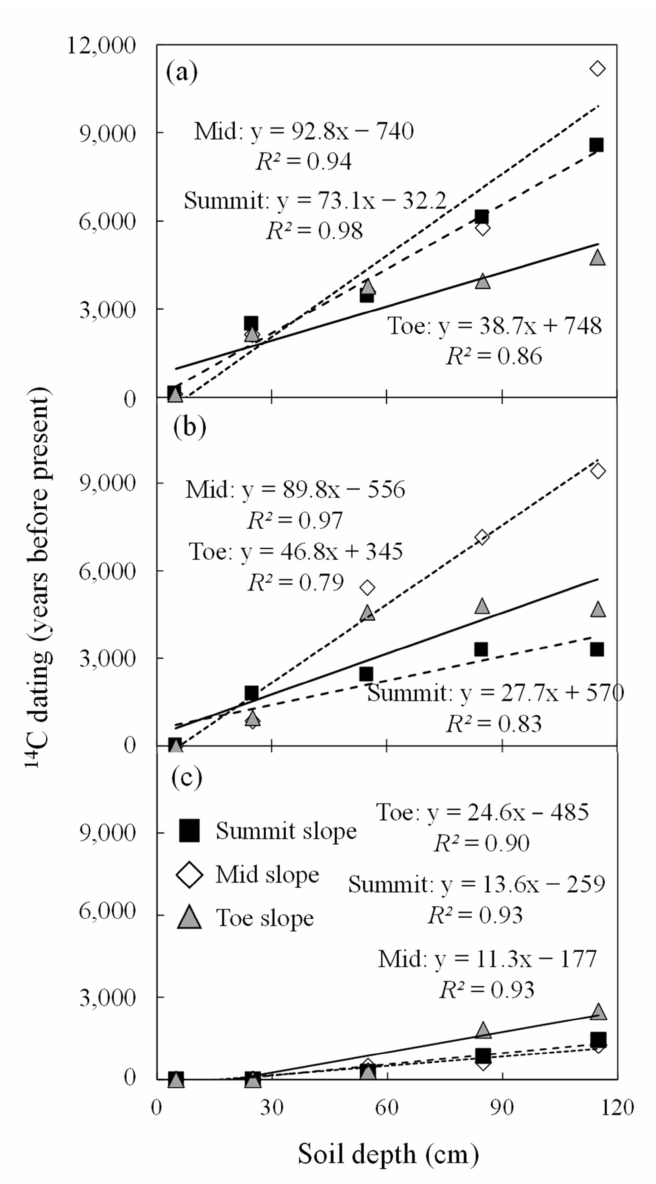
Figure 5. Calibrated radiocarbon ages to a 1.2 m depth of soil carbon at three catena positions (i.e., toe slope, mid-slope, and summit) in three semi-natural Miscanthus sinensis grassland sites in Japan: Kawatabi Field Science Center, Miyagi Prefecture (KAW) ( a ); Soni Plateau, Nara Prefecture (SONI) ( b ); Aso-Kuju National Park, Kyushu Prefecture (ASO) ( c